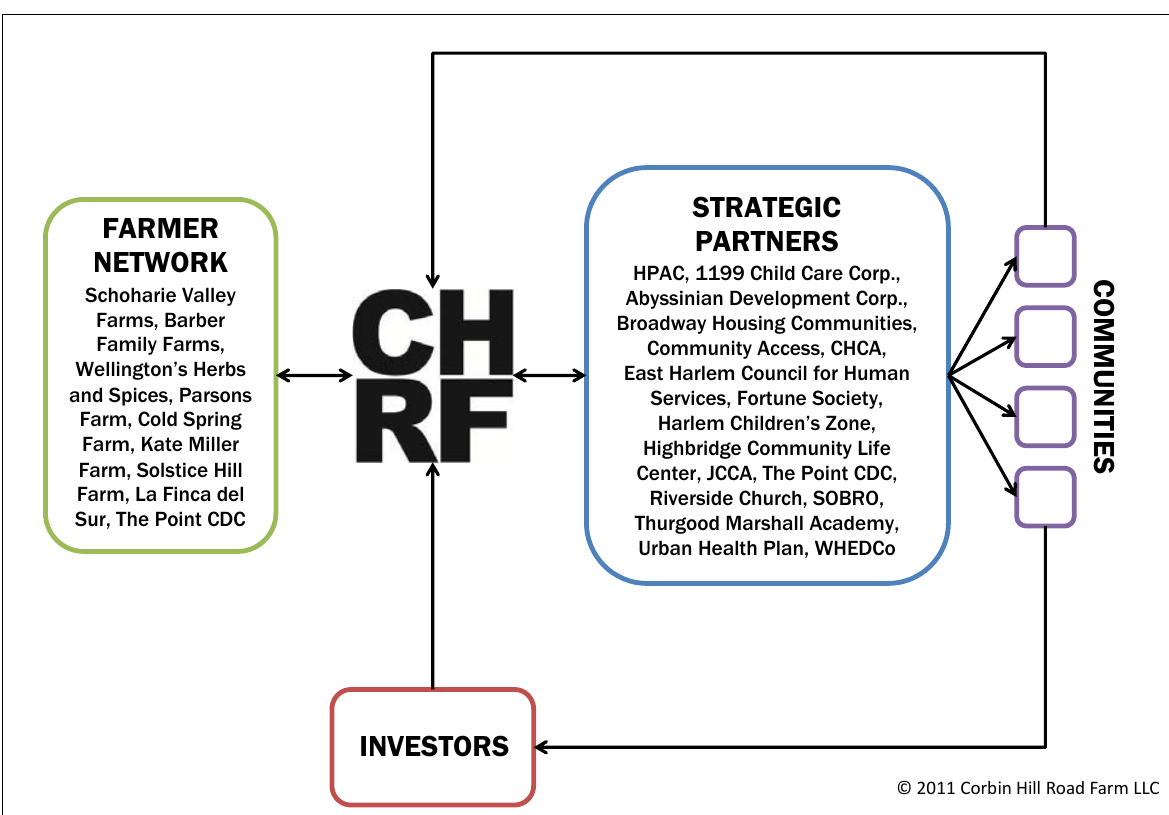
Figure 1. Corbin Hill Road Farm Share Hybrid Food Value Chain